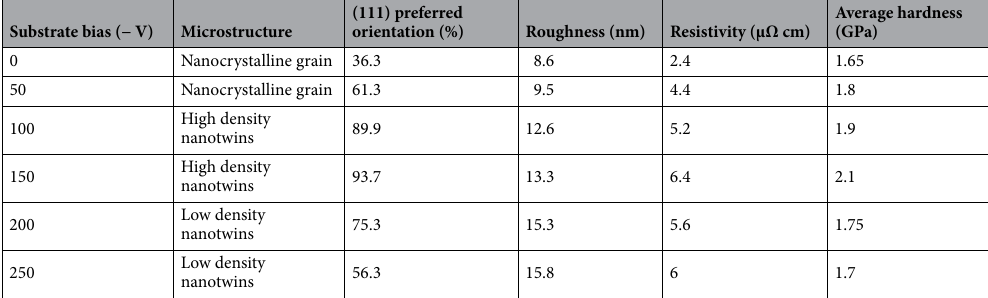
Table 1. Information of Cu nanotwinned films sputtered on SiC chips with various substrate biases.